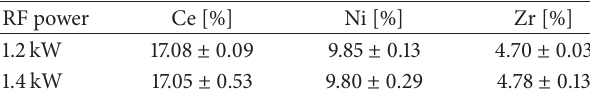
Table 3: Effect of the RF power used for cerium, nickel, and zirco- nium determination in the 100 mg L −1 slurries of Ni-CeZrO 2 /CNT hybrid material.